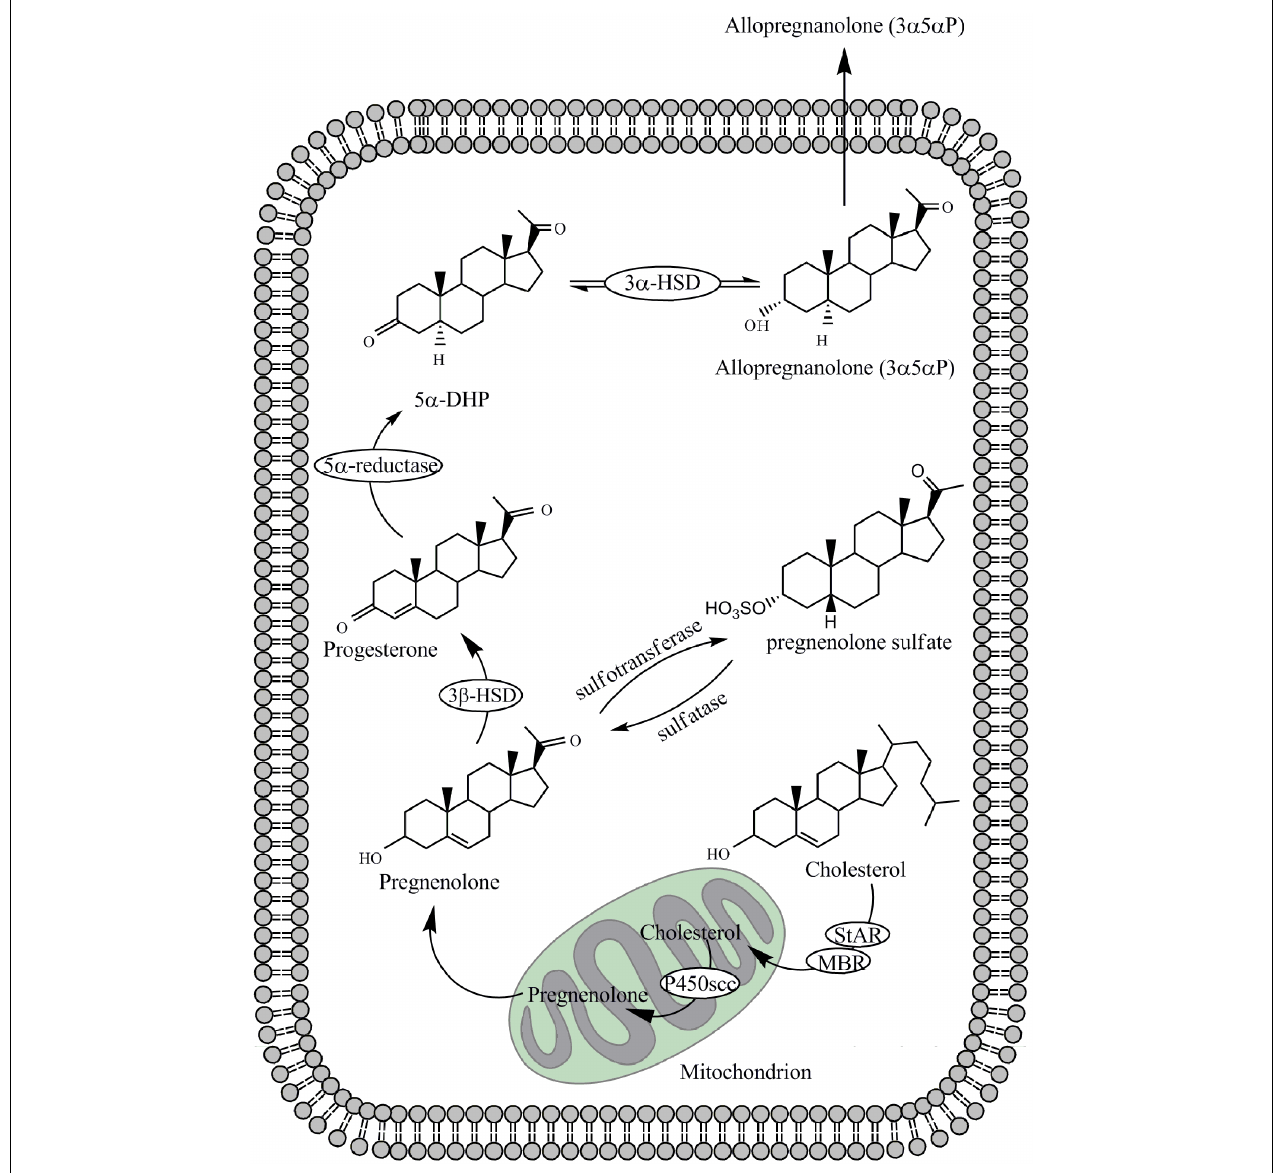
5 α -reductase.Transport of cholesterol across the mitochondrial membrane is enhanced by the steroidogenic acute-regulatory (StAR) protein and the mitochondrial benzodiazepine receptor (MBR). 5 α -DHP represents 5 α